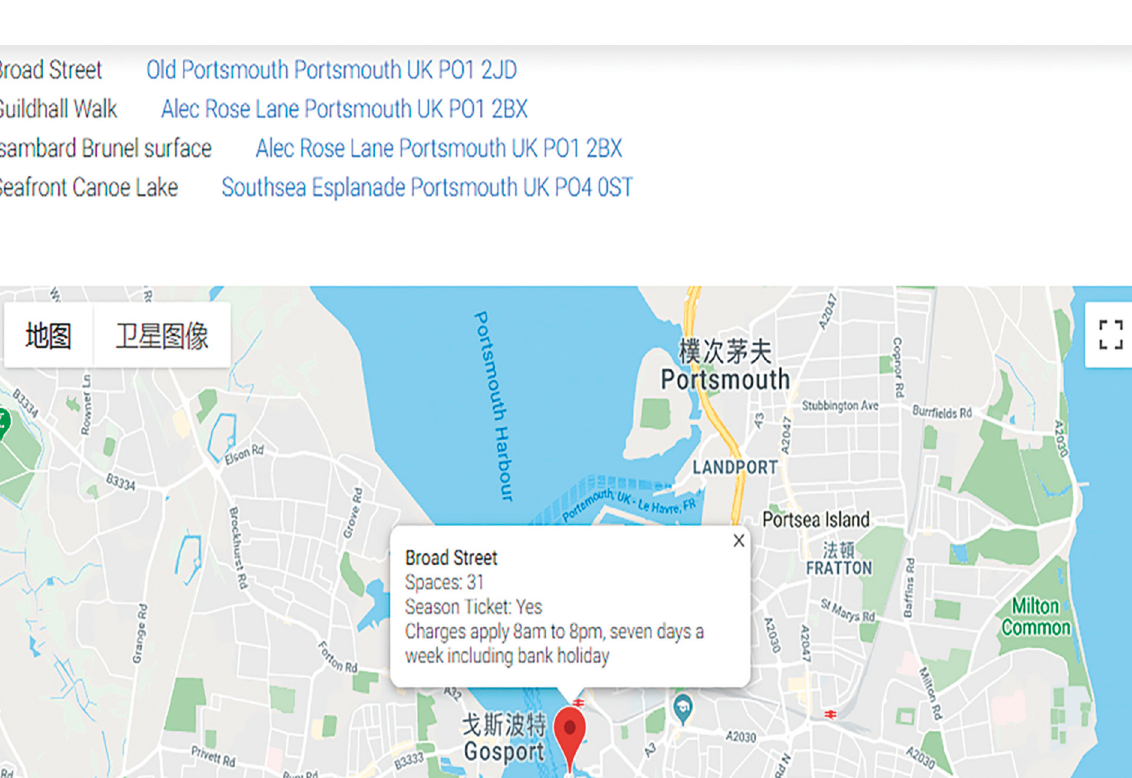
Figure 12: A car parking